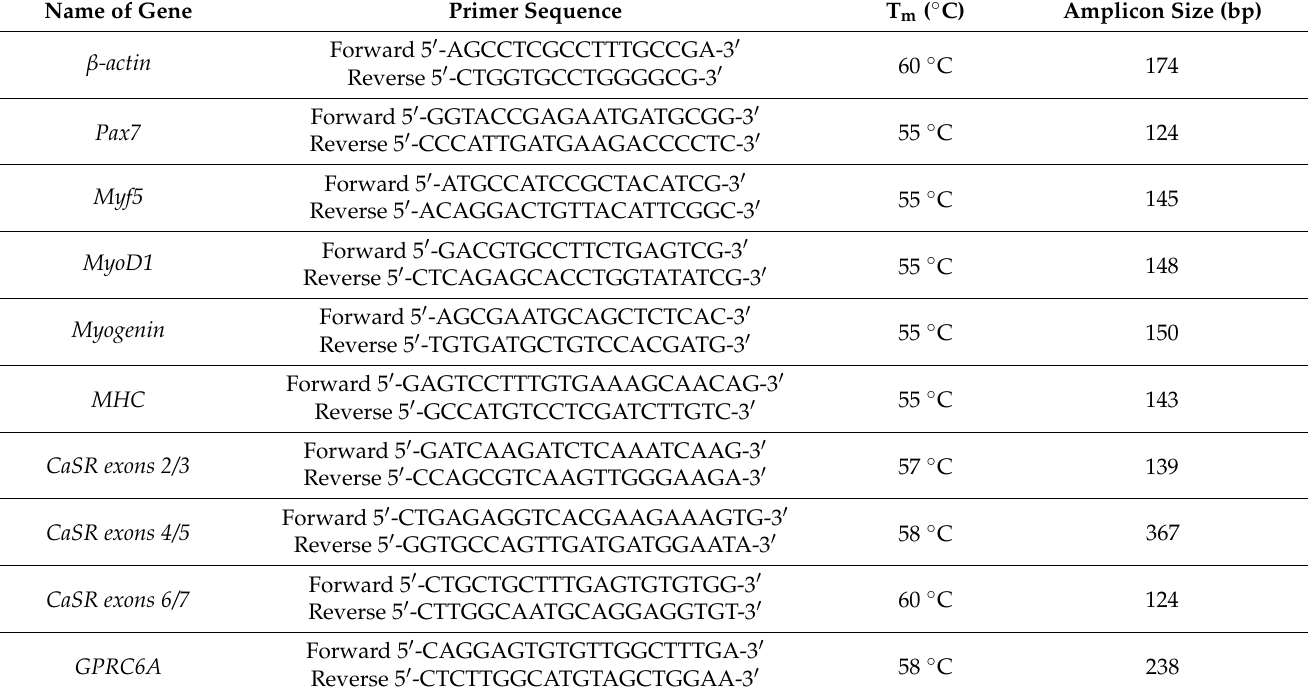
Table 2. List of the human gene-specific primers used in the